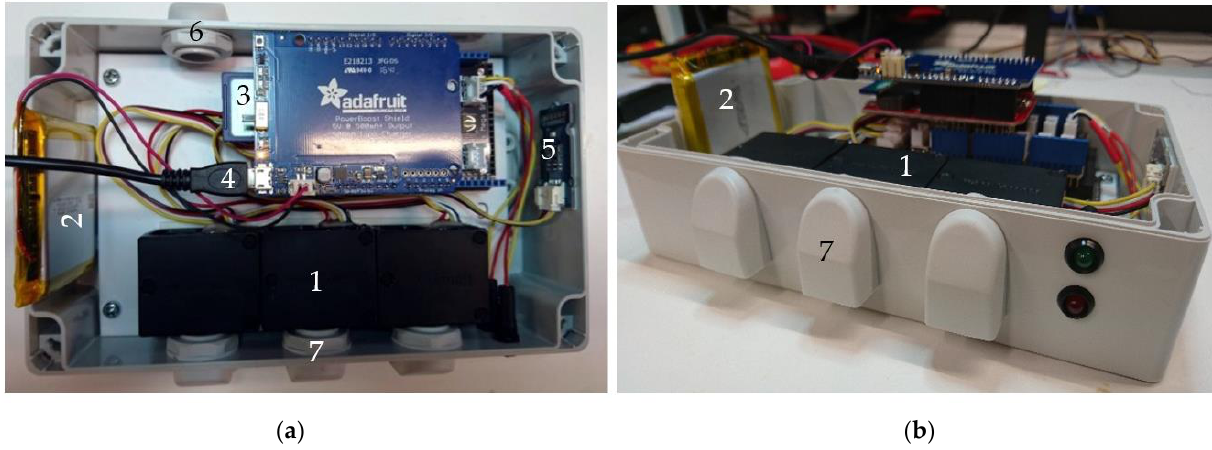
Figure 4. “3PM” device developed by the University of Liege. ( a ) Internal view with: 1. Tree Honeywell HPMA115S0 sensors, 2. Battery, 3. SD card, 4. µUSB connector for charging, 5. Temperature (°C)/relative humidity (%) and pressure (hPa), 6. Air outlet and 7. Air inlet. ( b ) Front of the instrument.